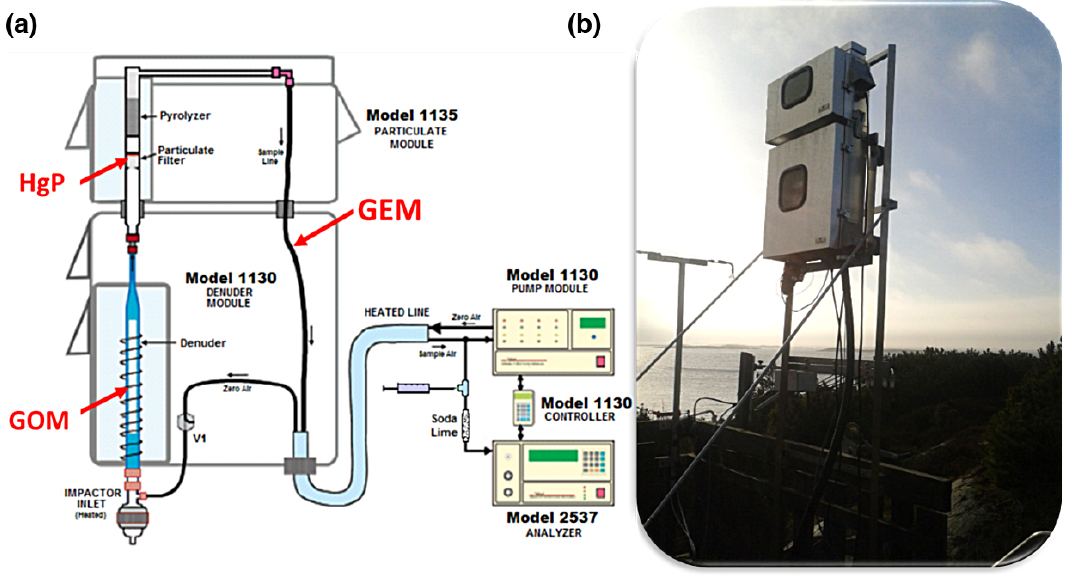
Figure 1. (a) A schematic overview of the Tekran mercury speciation system 1130/35 and the 2537 mercury analyser, (b) picture of the instrument operating at the Råö